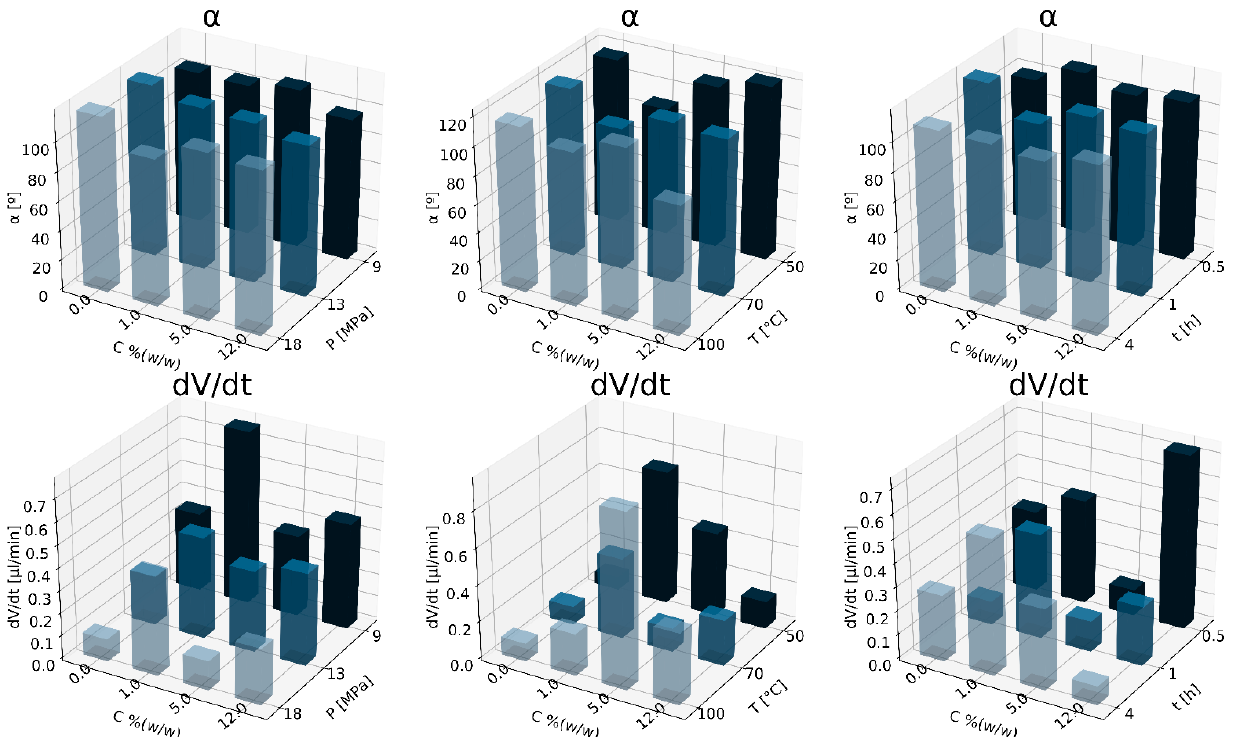
Figure 4. Influence of nC concentration for variable conditions of the foaming process: pressure P sat (9–18 MPa), T sat (50–100 °C) and saturation time t sat (0.5–4 h) on the contact angle ( α ), absorption rate (dV/dt).